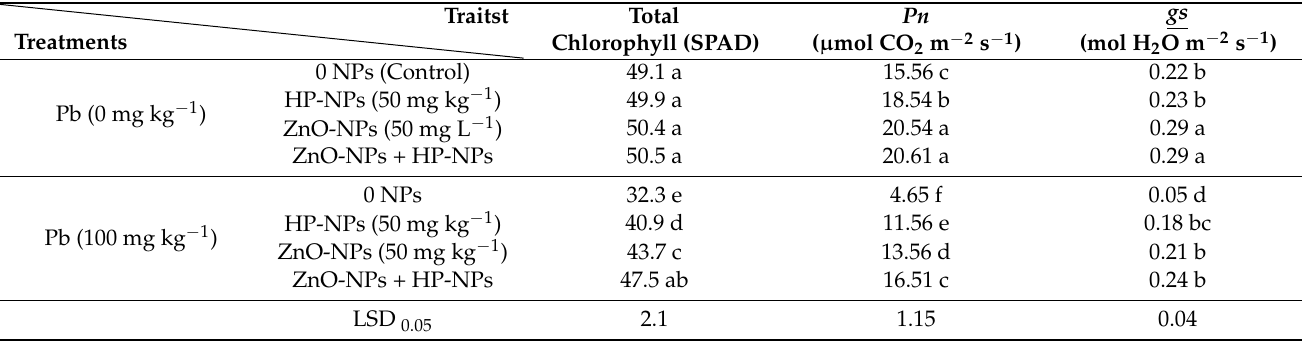
Table 2. Effects of nano-hydroxyapatite NPs (NH NPs), zinc oxide NPs (ZnO-NPs), and their combinations on total chlorophyll (SPAD), photosynthesis ( Pn ), and stomatal conductance ( gs ) of maize grown in soil contaminated with